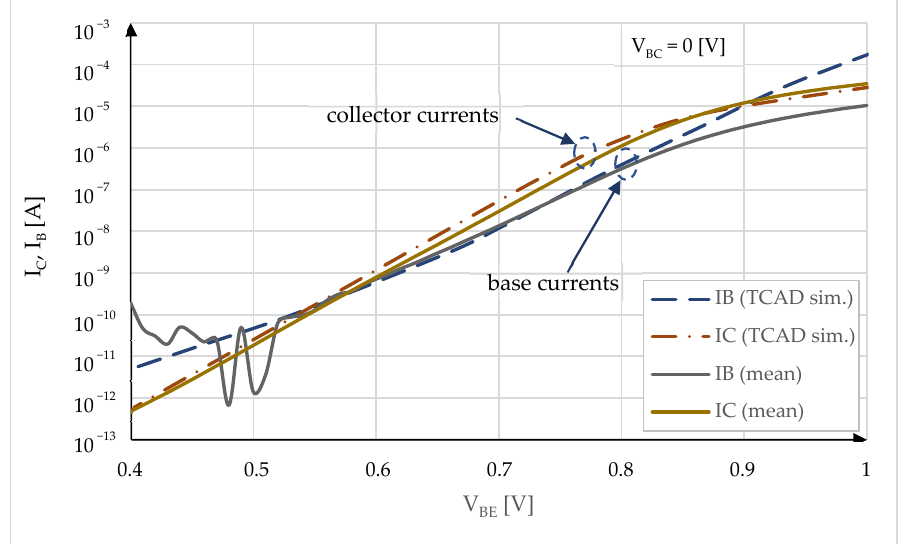
Figure 14. Comparison of averaged measurement results (solid lines) with the numeric simulation in TCAD (dashed lines).